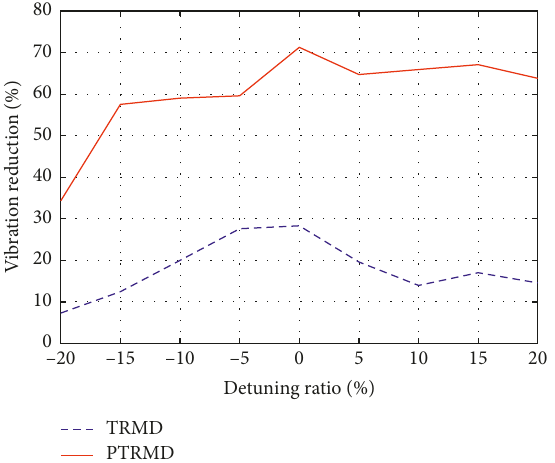
Figure 19: Reduction ratio of the TRMD and PTRMD with dif- ferent frequencies.